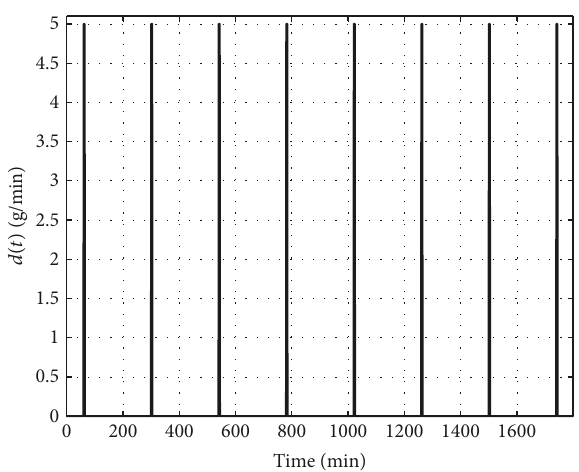
Figure 1: Applied disturbance (CHO intake)— 5 g over 5 minutes at each 240 th time